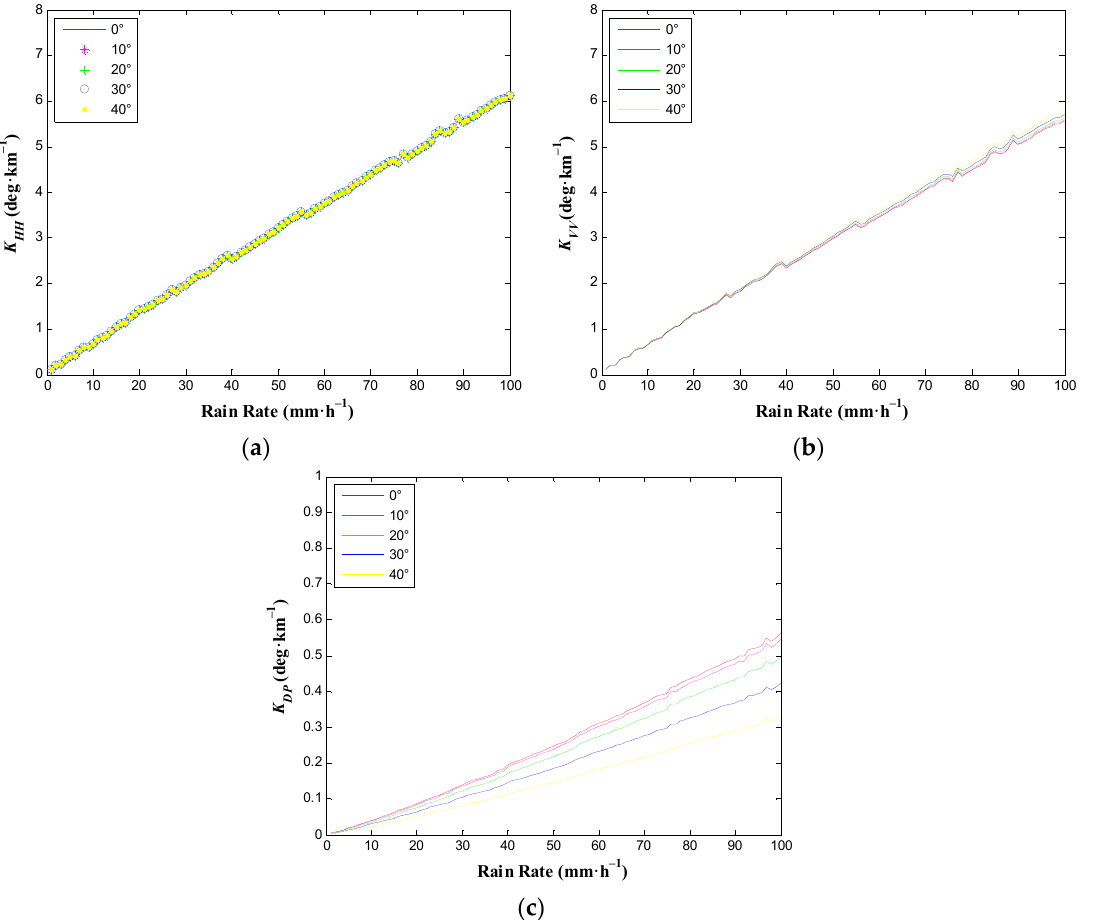
Figure 4. Polarimetric propagation parameters vs. rain rate for various elevation angles at the L1 (1575.42 MHz) frequency of GPS signals. ( a ) K HH - R ; ( b ) K VV - R ; ( c ) K DP - R .